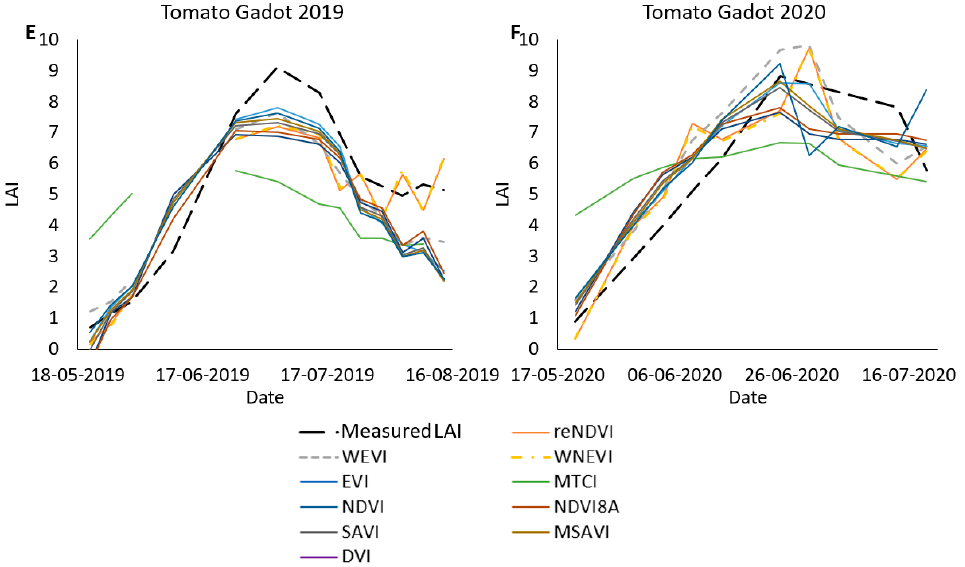
Figure 6. LAI measurements and LAI estimation based on the VIs used in the present study in the following experiments: ( A ) Wheat Saad, ( B ) Wheat Yavne, ( C ) Cotton Megido (centre of the field), ( D ) Tomato Gadash 2019, ( E ) Tomato Gadot 2019, ( F ) Tomato Gadot 2020.